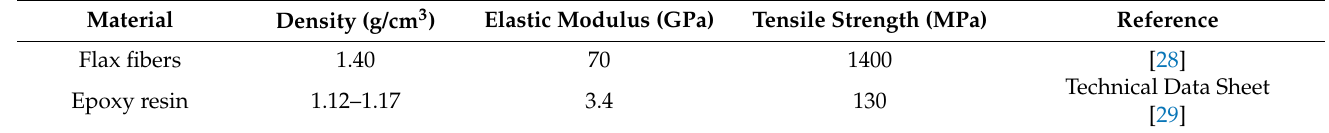
Table 1. Properties of flax fibers and neat epoxy resin.